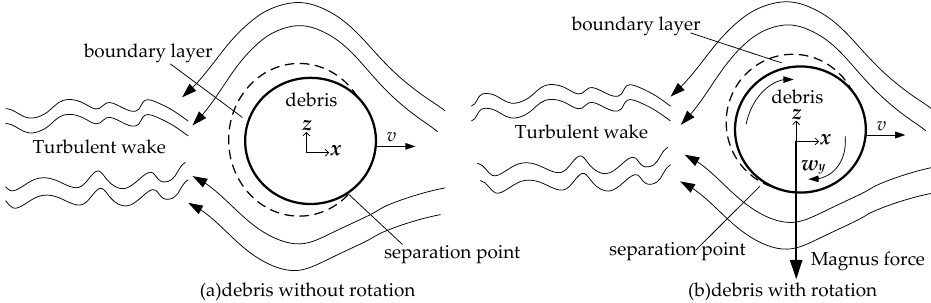
Figure 15. Flow patterns for liquid hydrazine past the debris without rotation ( a ) and the debris with rotation ( b ).